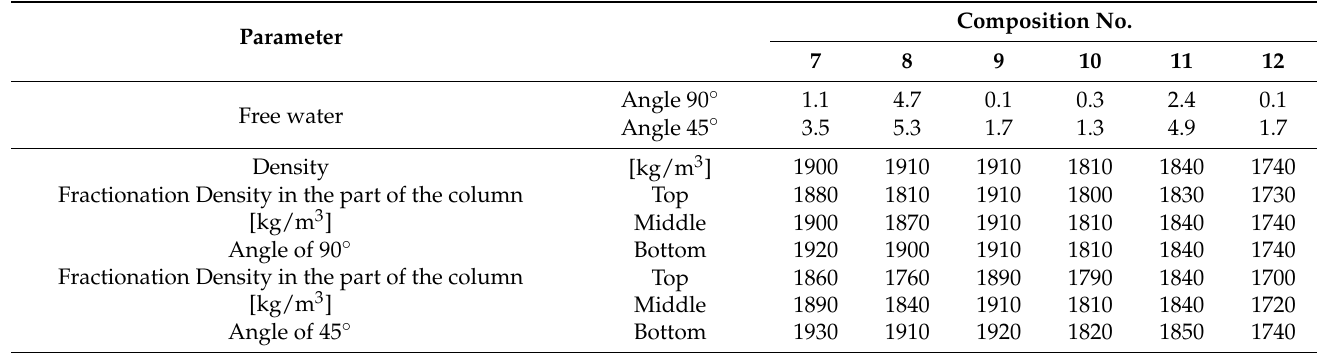
Table 4. Selected parameters of cement slurries based on class G